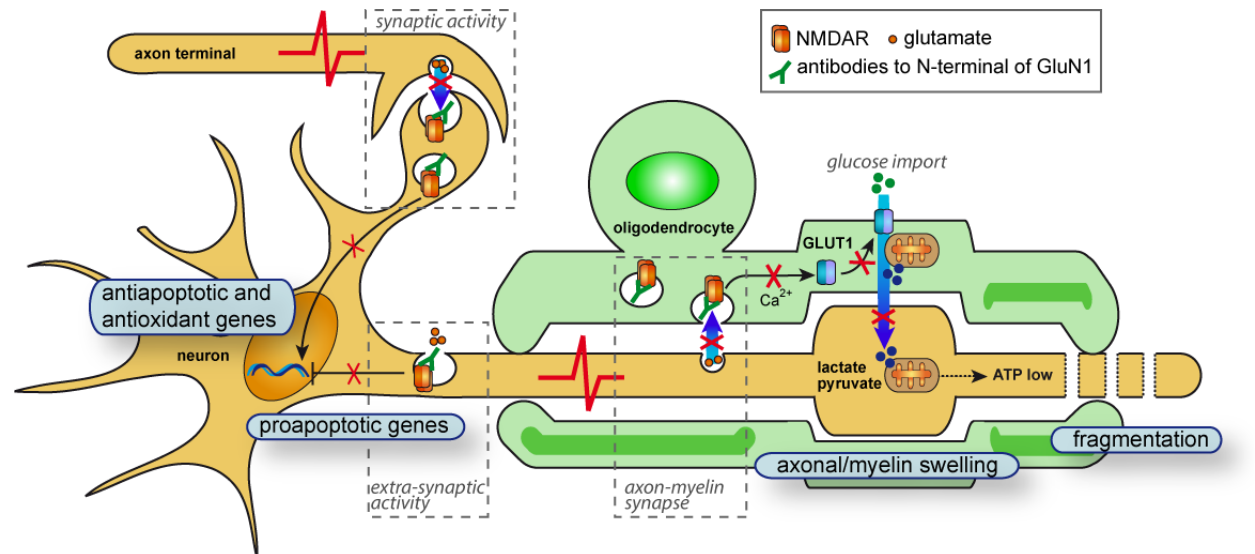
Figure 6. Graphic representation of the putative mechanisms involved in neurotoxic effects of human anti ‐ GluN1 autoantibodies on myelinated neurons. Anti ‐ GluN1 IgG1 may interfere with neurotransmission through NMDARs localized at different parts of neuron. Targeting NMDAR at axon ‐ myelin synapses will affect glutamate ‐ mediated localization of glucose transporter (GLUT1) to surface membrane of oligodendrocyte and diminish trophic support of the axon. Subsequently, the insufficient local ATP production by axonal mitochondria may trigger neurodegenerative processes at internodes. Anti ‐ GluN1 ‐ mediated surface depletion of extra ‐ synaptic NMDARs may affect inhibitory effects of basal NMDAR activity on expression of proapoptotic genes, such as Apaf1 , Bid , Puma . Lowering synaptic NMDAR signaling may interfere with its known role in CREB ‐ mediated neuronal survival, neuroprotective μ‐ calpain activation, antiapoptotic and antioxidant gene expression.